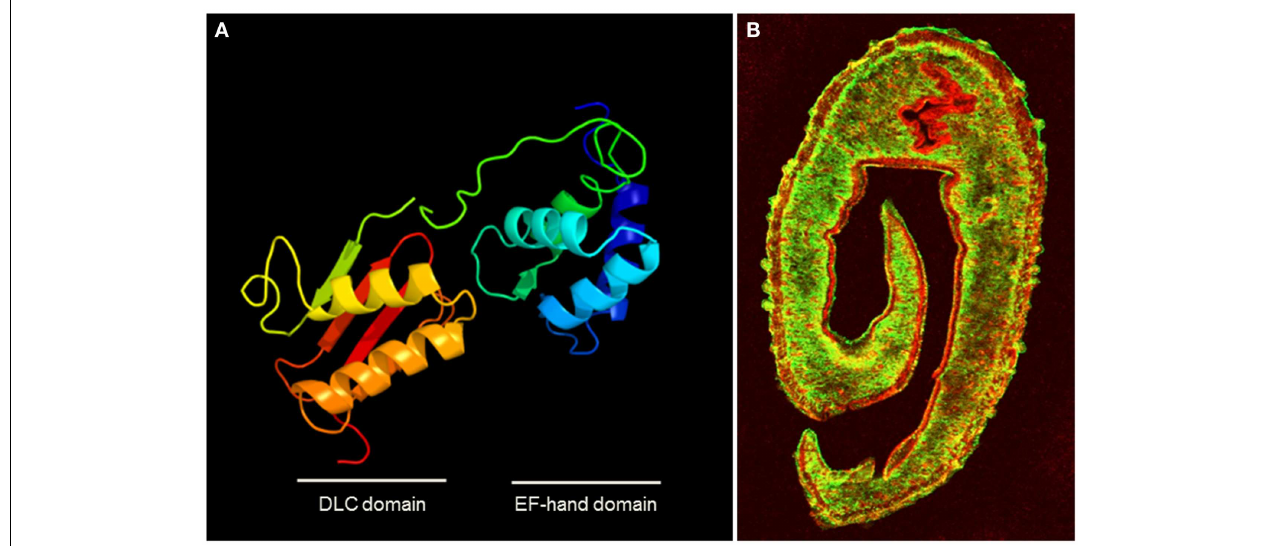
tegument layer, the EF-hand protein SmTAL1 (red) (courtesy of Prof. Alan Wilson University ofYork).The walls of the gut also stain for SmTAL1.The location illustrates how this sub-surface allergen in inaccessible to host IgE, unless the tegument layer is damaged, but its physiological function and role in host protection remain to be